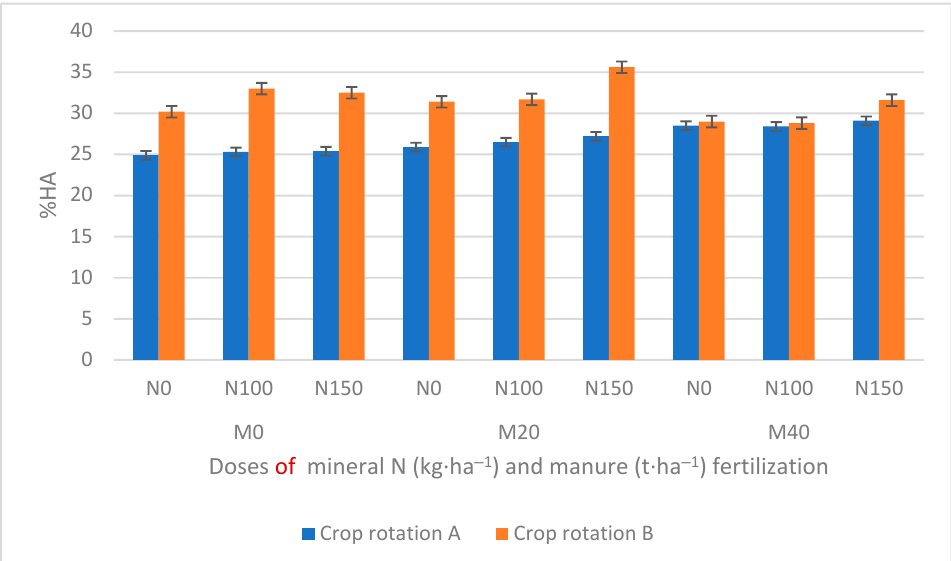
Figure 3. Humic acids (HA) contents in in the topsoil layer (0–30 cm) as influenced by crop rotation (I), manure application (III) and mineral N rate (III) in the long-term field experiment at Grabow, Poland. Error bars denote standard deviations ( n = 3). LSD ( p ≤ 0.05): for I = 0.318, II = 0.509, III 0.459, II/I = 0.720, I/II = 0.661, III/I = 0.650, I/III = 0.606, III/II = 0.796, II/III = 0.824.